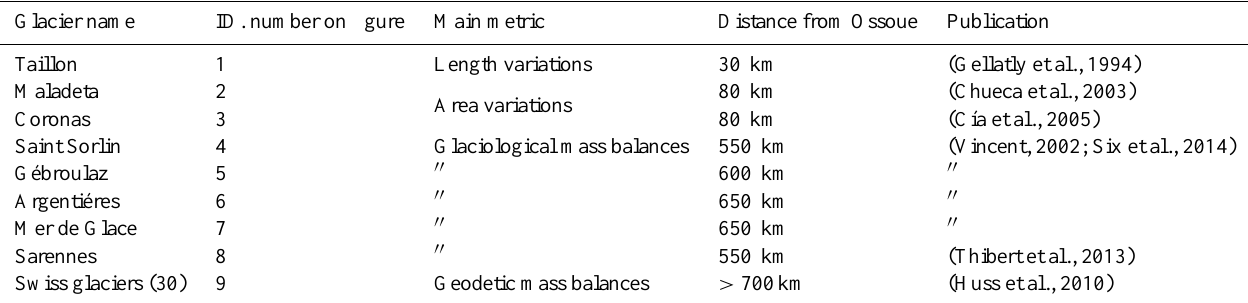
Figure 4. Map designed by Meillon and Larminat, with focus on Vignemale glaciers, 1933 edition (glacier data are from 1924). Table 4. Meta-data of glacier variations from the literature used in this study for comparison between Ossoue and others Pyrenean and Alps glacier